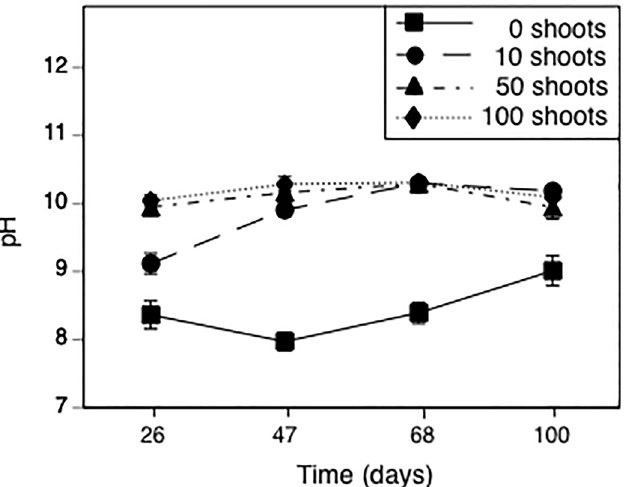
Fig 1. The effect of treatments planted with different initial numbers of Elodea shoots on pH over time. Data are means ± 1 SE.